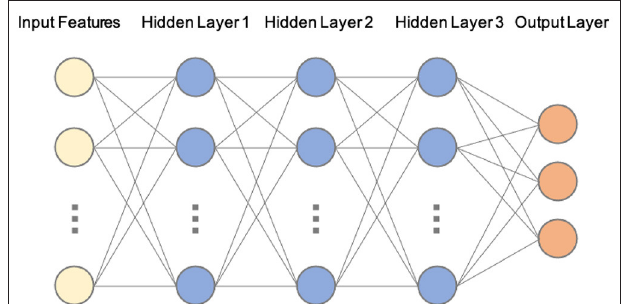
FIGURE 4 | Example schematic of our current architecture of the artificial neural network (ANN). Our current ANN translates input features (from OpenFace) into three outputs (looking left, center, or right). Each node has an associated set of parameters (weights and biases) that generates an output. If the output of any individual node is above a specified threshold value, that node will pass data to the next layer of the network. Otherwise, no data will be sent to the next layer of the network. This powerful mechanism can be applied to modeling a plethora of problems that involve generating output values based on some input values. The “learning” or “training” process involves finding the optimum parameters for each node to minimize a cost function, which ultimately improves their accuracy. In order to improve the efficiency of model training, we included several standard regularization techniques. Specifically, each layer is followed by 1-D batch normalization (Ioffe and Szegedy, 2015 ) and a dropout procedure with the probability of 0.2 ( Srivastava et al., 2014). We used the widely popular Rectified Linear Units (ReLUs) activation function (Nair and Hinton, 2010) at each